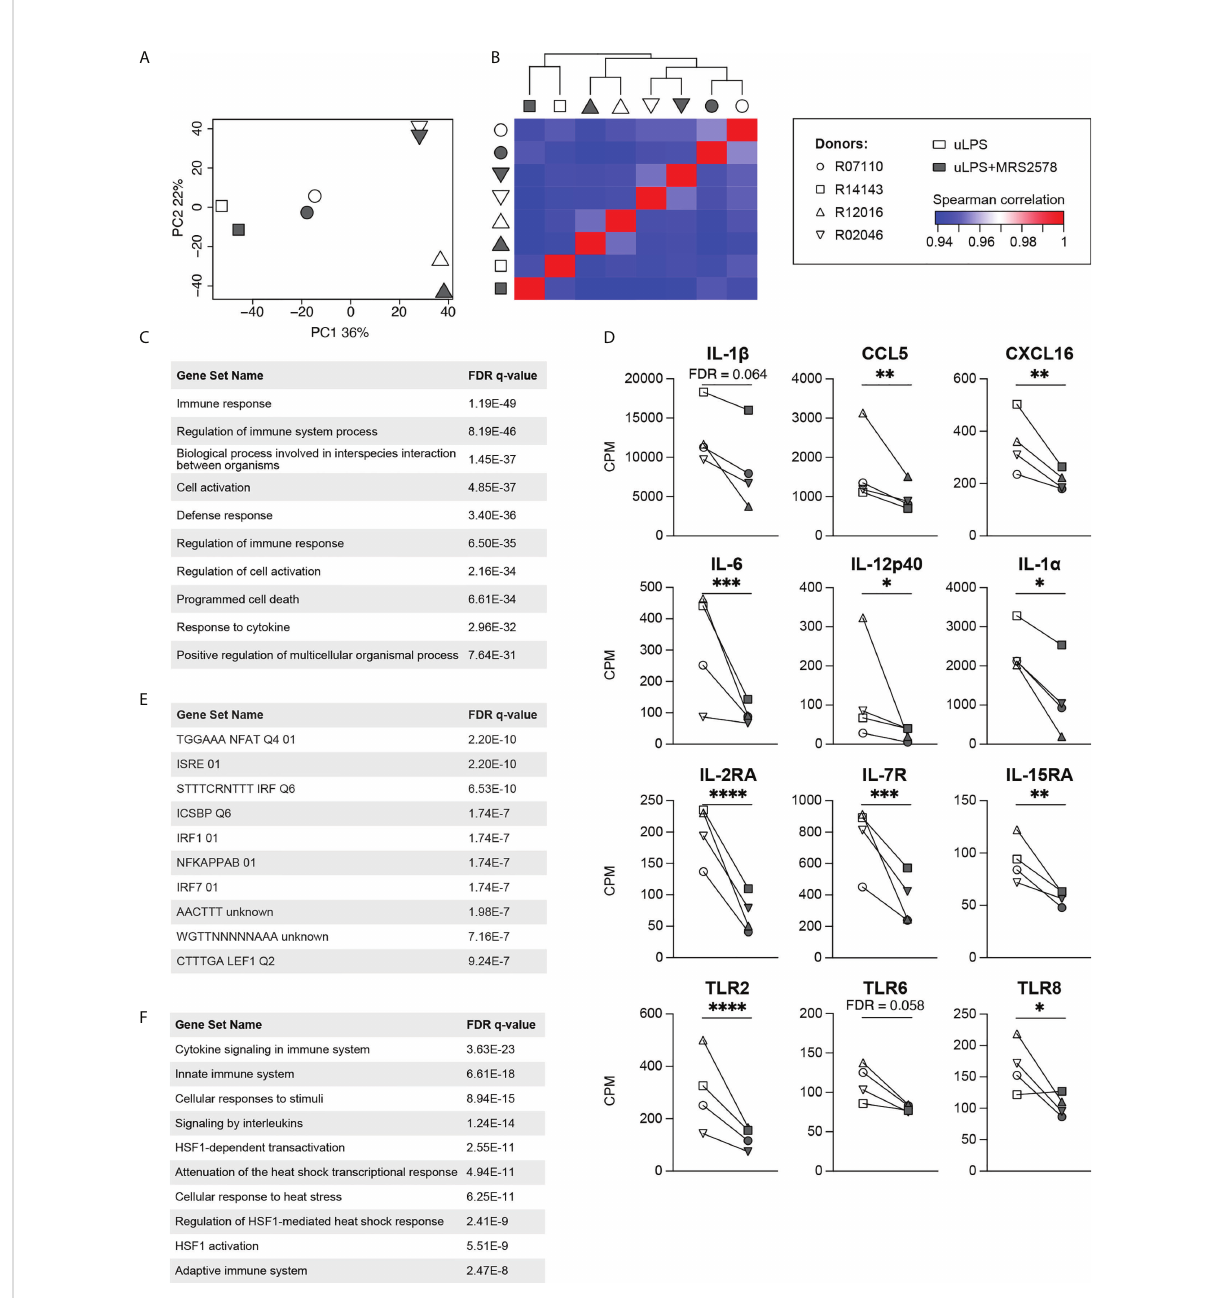
FIGURE 3 Effects of P2RY6-mediated signaling on the transcriptomes of uLPS-exposed primary microglia. (A) Principal component analysis and (B) Spearman correlation heatmap of the transcriptomes of primary microglia from four adult rhesus macaques exposed to 10 µg/mL uLPS (TLR4), with (grey symbols) or without (white symbols) 1 h pre-incubation with 5 µM P2RY6 antagonist MRS2578. n=4, symbols represent different donors. (C) Biological processes associated with the 302 differentially expressed genes were analyzed using the molecular signatures database (MSigDB). FDR = false discovery rate. (D) Gene expression levels (CPM) of several genes associated with immune responses. Microglia were exposed to uLPS, with (grey symbols) or without (white symbols) 1 h pre-incubation with MRS2578. n=4, EdgeR false discovery rates (FDR) are used to display statistical differences, *FDR < **FDR < 0.01, ***FDR < 0.005, ****FDR < 0.001. (E) Transcription factor target analysis of the downregulated genes in the presence of P2RY6 antagonist analyzed using MSigDB. FDR = false discovery rate. (F) Canonical pathways associated with the 302 differentially expressed genes were analyzed using MSigDB. FDR = false discovery